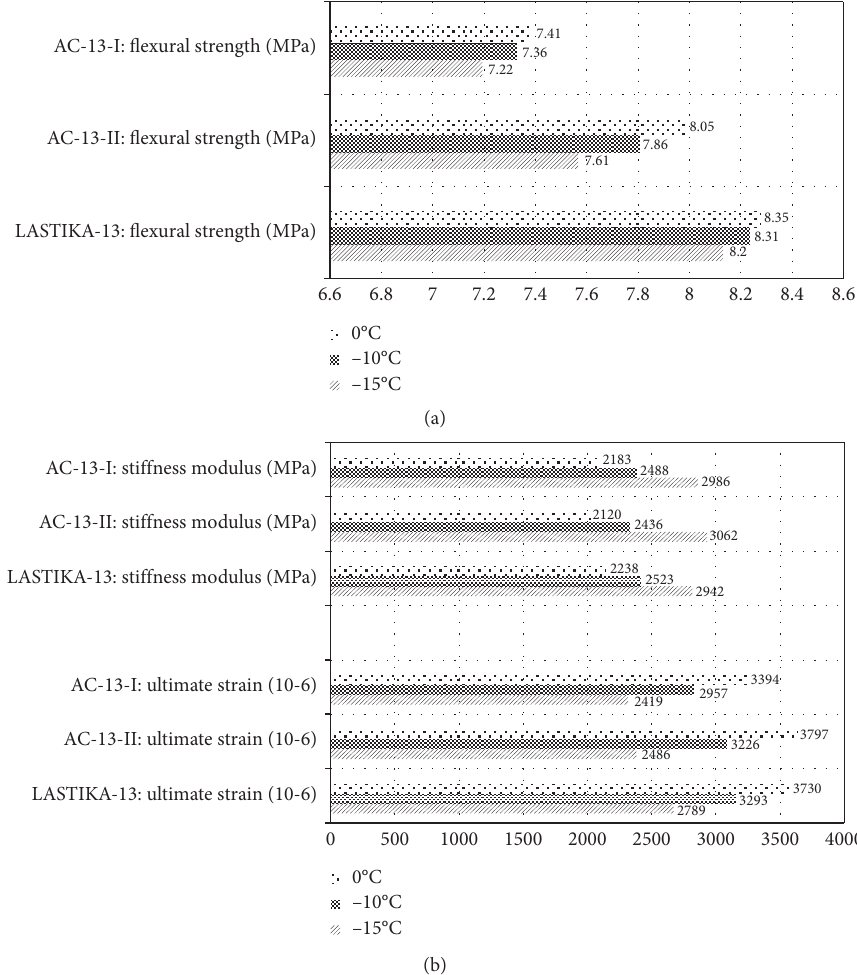
Figure 7: Bending beam test results of asphalt mixtures at different temperatures: (a) The flexural strength of asphalt mixtures with different temperatrues. (b) The stiffness modulus and ultimate strain of asphalt mixtures with different